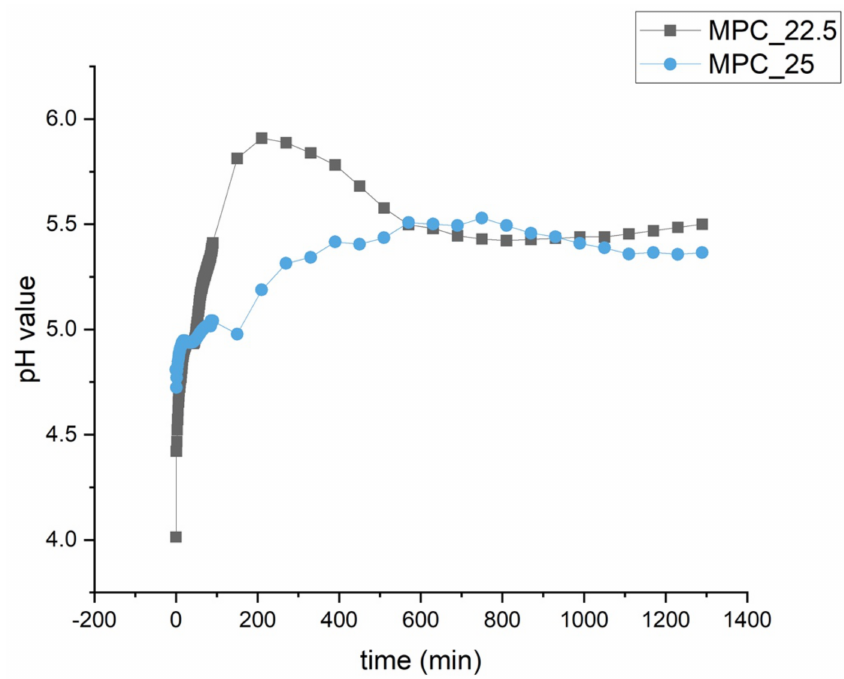
Figure 6. pH profile during the setting of MPC_25 and MPC_22.5. During the first 10 h, values are slightly lower for MPC_25. Both formulations approach a value of approximately 5.5 in the second half of the